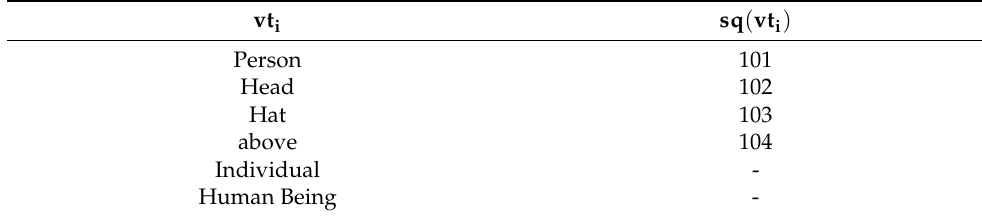
Table 2. Exemplary function, sq ( vt i ) , and values for GC ex